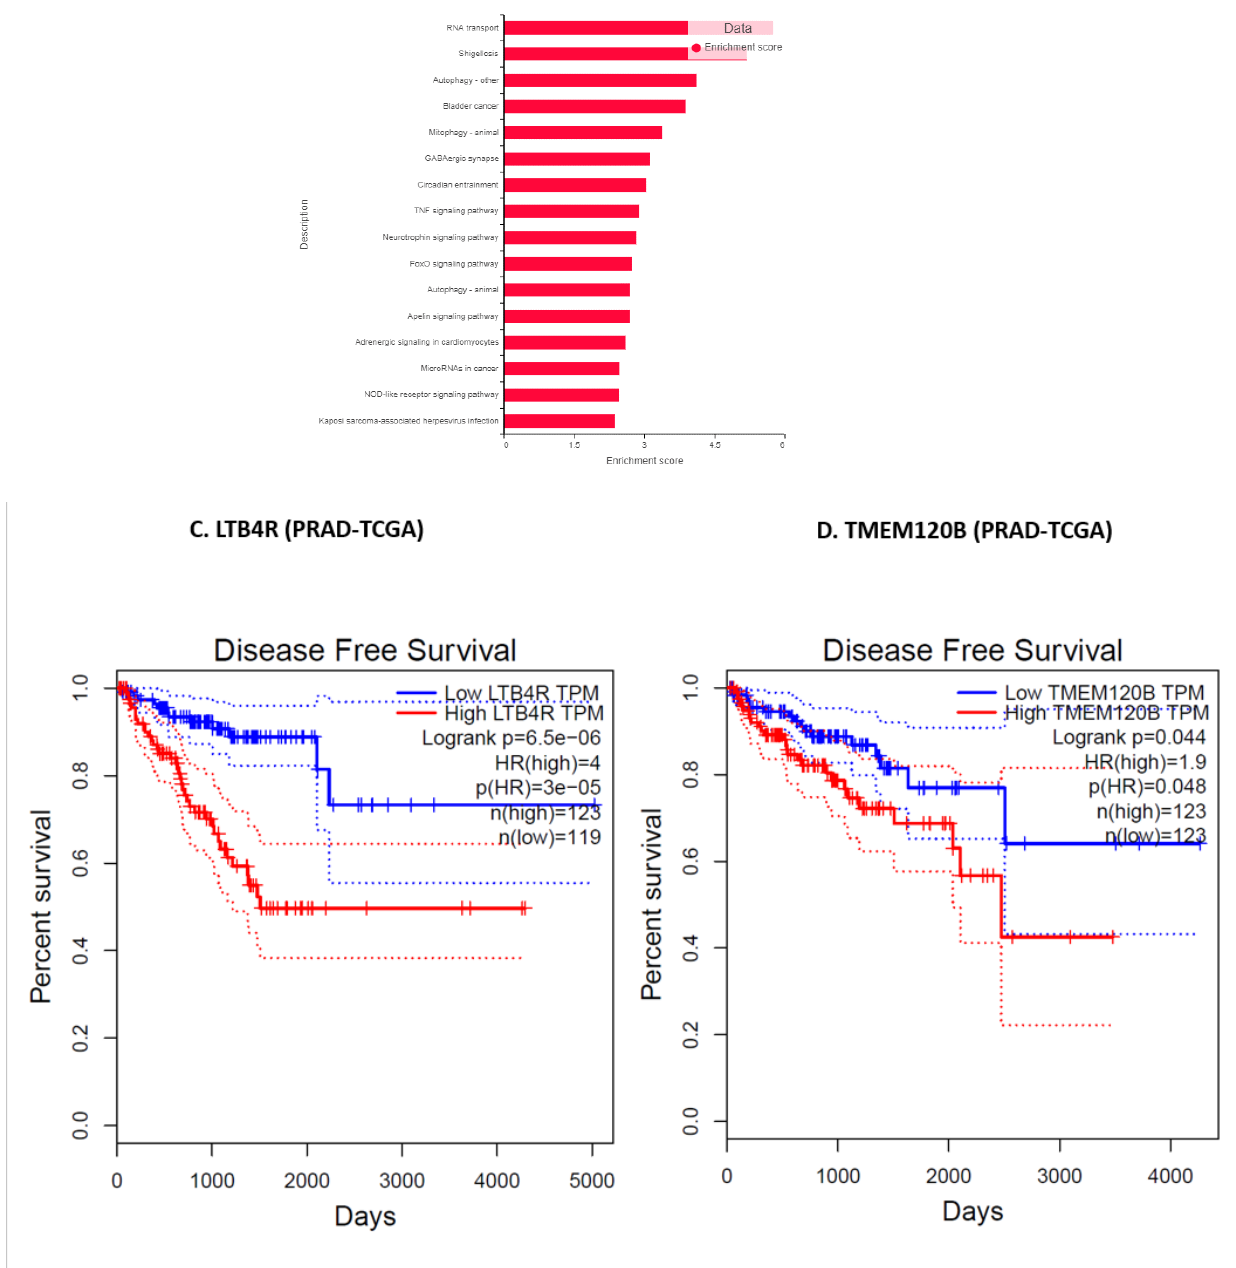
Figure 10. Validation of FK866 treatment-related gene signatures using patient cohort datasets. Reverse-matching using patient cohort datasets show FK866 treatment has the potential to reverse PCa lethality. Pathway analysis was performed based on the top DEGs in ( A ) PCa patient cohort; ( B ) Top FK866 treatment-induced upregulated pathways that were significantly downregulated in PCa patients with BCR. Validation using TCGA’s prostate adenocarcinoma (PRAD) GEP dataset: In silico analysis of the top FK866 treatment-induced downregulated pathways (Table S3) that were significantly downregulated in PCa patients with BCR using TCGA’s PCa dataset: Kaplan-Meier Curves showed that the genes ( C ) LTB4R, and ( D ) TMEM120B were significantly associated with disease-free survival.